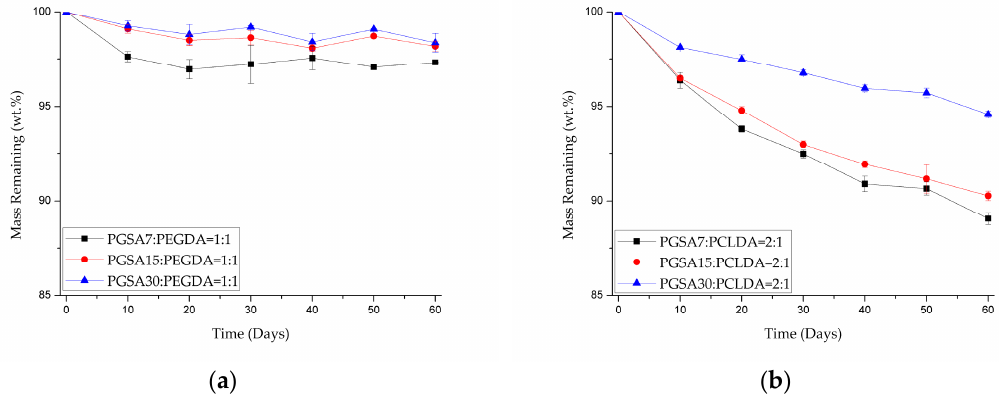
Figure 4. Mass remaining of ( a ) PGSA- co -PEGDA in 1:1 ratio and ( b ) PGSA- co -PCLDA in 2:1 ratio with various degree of acrylation degraded by 20 U/mL of lipase solution over 60 days at 37 °C.